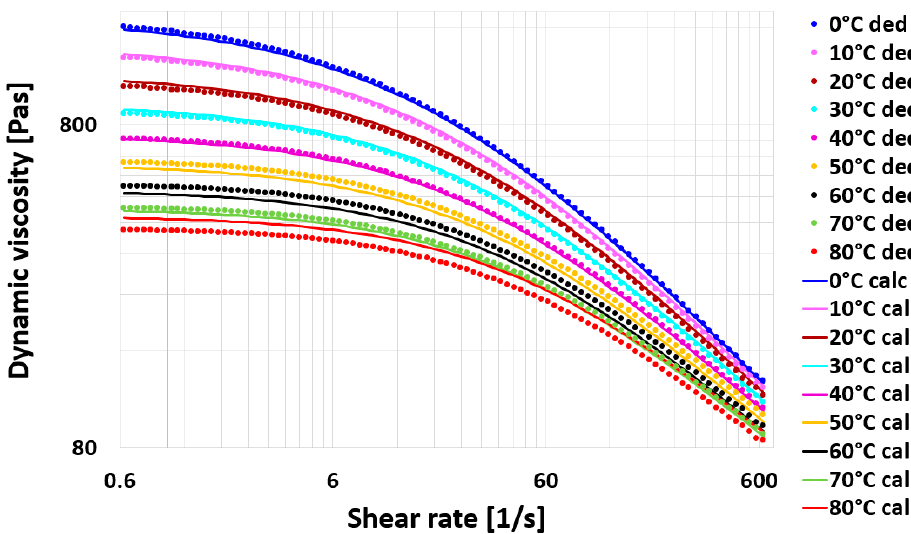
Figure 5. Deduced viscosity data (dots) and viscosity curves (lines) calculated by the fitted model parameter curves.